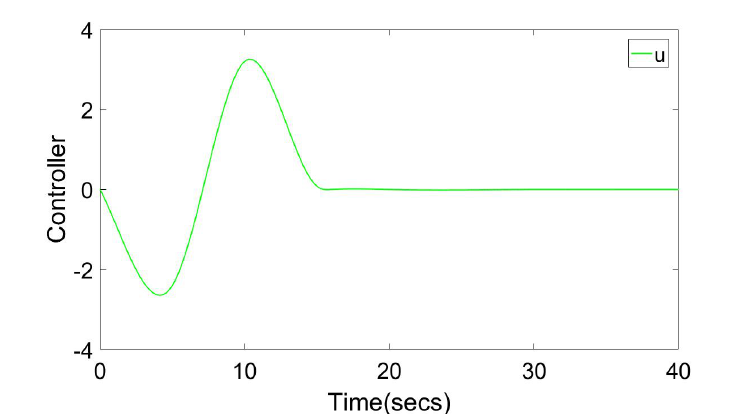
Figure 9. ( a ) State l 1 under PID controller; ( b ) state l 2 under PID controller.